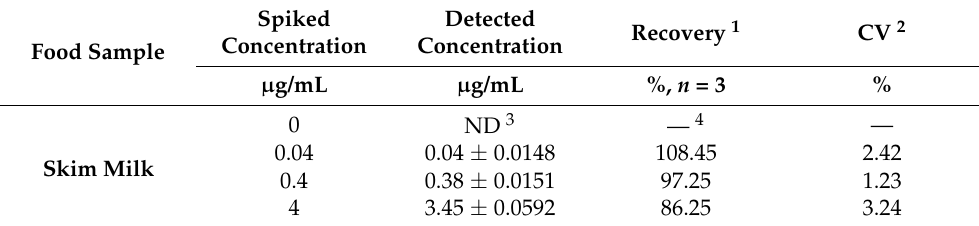
Table 1. Recoveries of lupine allergen in milk samples tested by sandwich ELISA. Spiked Detected Recovery 1 CV Concentration Concentration Food Sample